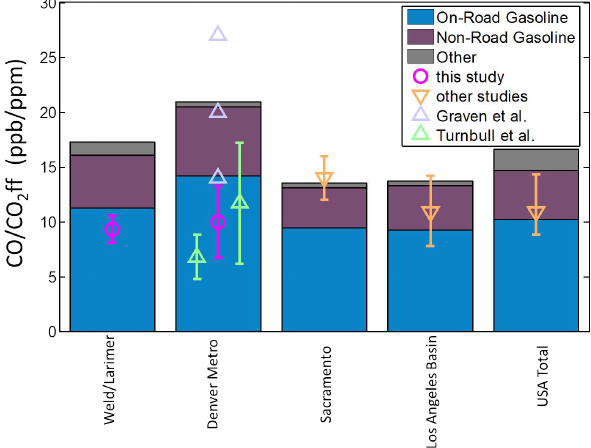
Fig. 5. A comparison of CO/CO 2 ff ratios observed or estimated in various US locations. The bars are calculated from bottom-up emis- sions estimates (NEI08 CO and Vulcan2.2 CO 2 ) and color-coded by the contribution of different sectors to the total CO emissions: on-road gasoline, non-road gasoline, and other. Observations from each location are shown, including those from our observations at BAO (split into Weld/Larimer and Denver metro influence based on wind sector) and observations from other studies: Denver (Turn- bull et al., 2006; Graven et al., 2009)), Sacramento (Turnbull et al., 2011), LA Basin (which includes Los Angeles, Riverside, Orange, and San Bernardino counties) (Djuricin et al., 2010), and for the northeastern US (Miller et al., 2012).